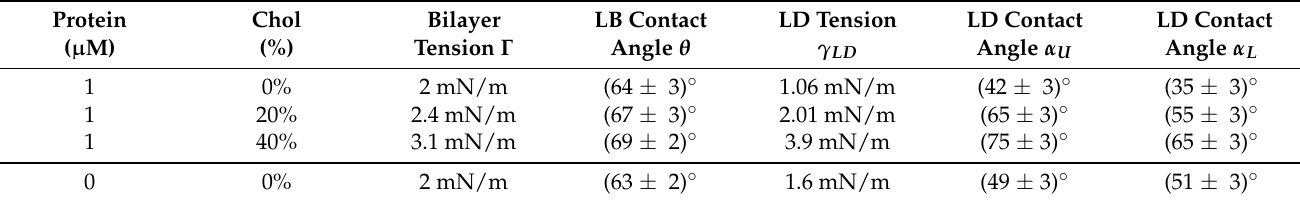
Table 1. Physical characterization of a symmetric bilayer and LDs inserted in it. The phospholipids diffused between the monolayer covering the LD and the bilayer, so the LD monolayer’s phos- pholipidic composition was the same as that of the bilayer after a long time. LD surface tension γ LD was obtained from pendant drop measurements, bilayer tension Γ was obtained from optically determined contact angles θ and γ LD using Equation (2), and LD contact angles were obtained from 3D confocal micrographs. Each value was obtained by averaging 30 different